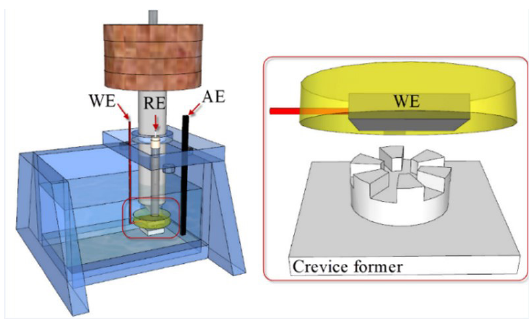
Figure 3. X-ray diffraction patterns for DSS UNS S32205 samples in the base metal (BM; blue) and in the weld metal (WM; red) regions and corresponding Miller